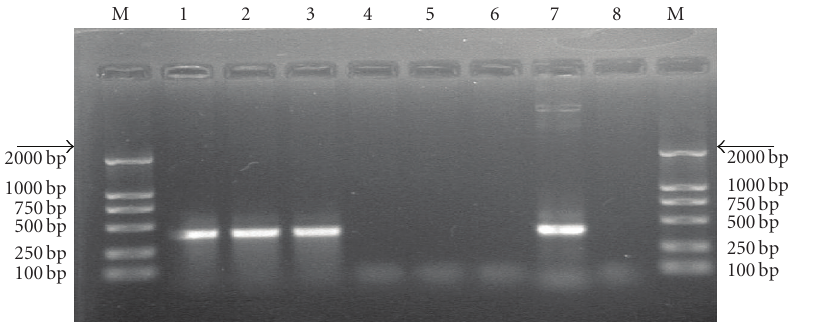
Figure 5: PCR product of HBs gene: M: Markers; 1, 2, and 3: the samples from three single embryos with green fluorescence showing HBs DNA positive bands, respectively; 4, 5, and 6: the samples from three single embryos without green fluorescence showing negative results for HBs DNA; 7: the positive control; 8: the negative control.